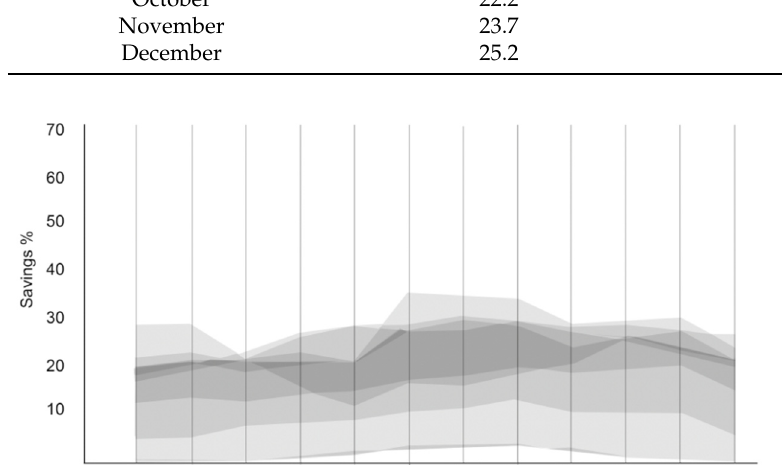
Figure 7. Monthly cooling load reduction for cockpits. Each grey area represents a thermal zone, and the darker color indicates a higher density of zones within that savings range.